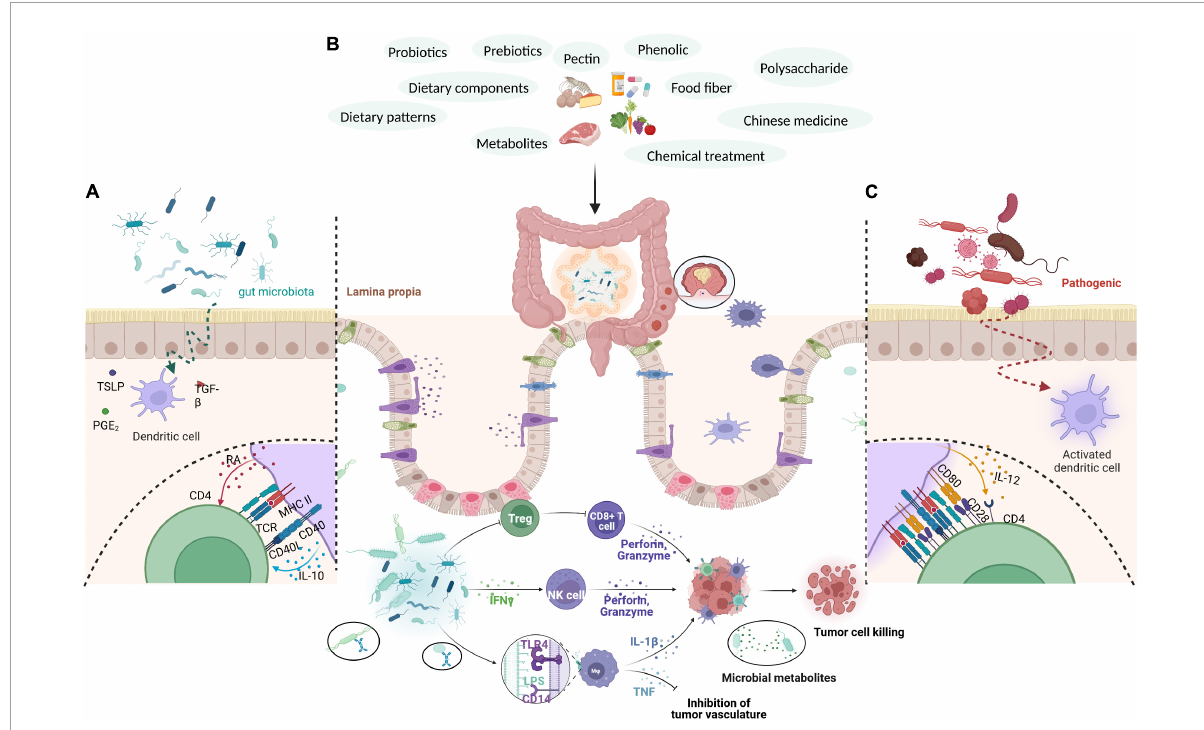
FIGURE2 Through external intervention measures, such as the use of probiotics, prebiotics, polysaccharides, pectin, polyphenols, plant fibers, bacterial metabolites, drugs, and diet, the richness of intestinal flora is increased, intestinal immunity is regulated, the immune response of the body is enhanced, the secretion of anti-cancer cytokines is increased, and the colorectal mucosa is protected, thereby effectively intervening in CRC. (A) Gut microbiota produce substances such as PGE2, TGF- β , and TSLP to inhibit the maturation of dendritic cells (DCs). Immature DCs give weak co-stimulatory signals and secrete cytokines such as RA and IL-10 to induce CD4T cells to differentiate into Treg cells. (B) Gut microbiota induces the formation of T cells, secretes INF- γ , and activates NK cells. After contacting the intestinal epithelium, it enhances the phagocytic activity of macrophages through the receptor pathway, promotes cytokines such as TNF and IL, stimulates the body’s immune response, and exerts an anti-tumor effect. (C) Intestinal pathogenic bacteria penetrate the intestinal epithelium to activate DCs. The activated DCs express strong costimulatory ligands and induce CD4T cells to differentiate into effective TH1 and TH17